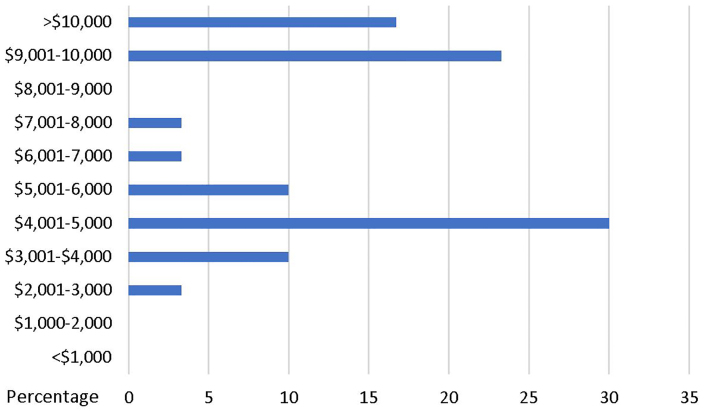
Amount of fellowship funding.4